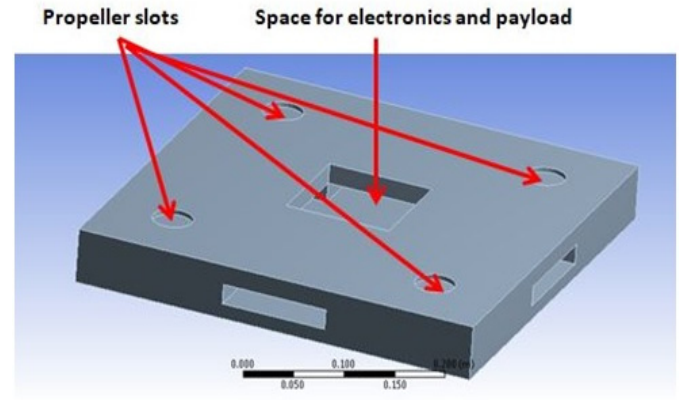
Figure 3. Initial geometry.